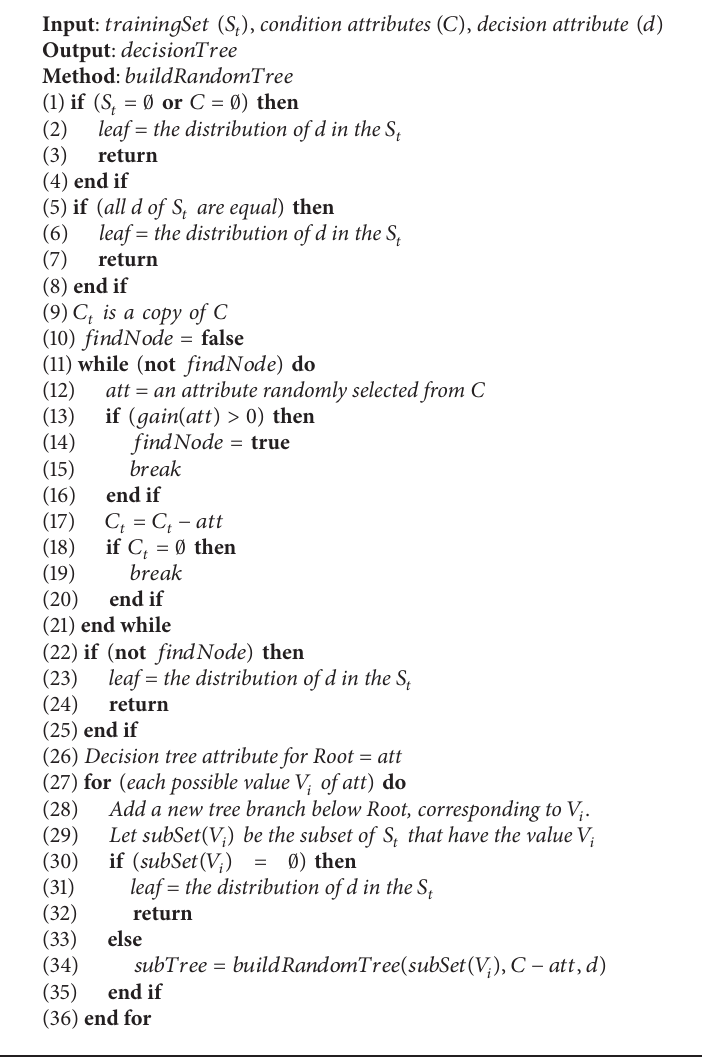
Algorithm 1: Random decision tree.